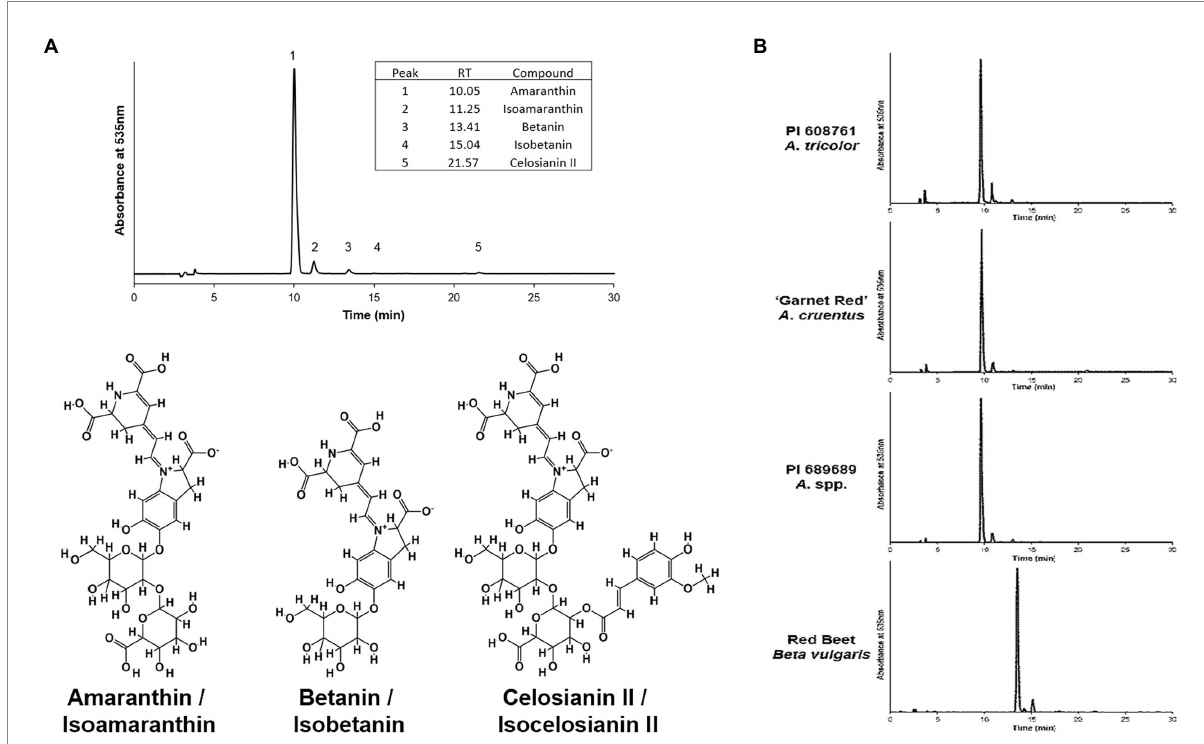
FIGURE 1 (A) Representative HPLC chromatogram of an A. cruentus extract (PI 566897) using the analysis method described by Cai et al. (2001a). Example normalized chromatograms of PI 608761 ( A. tricolor ), ‘Garnet Red’ ( A. cruentus ), PI 689689 ( A. cruentus ), and an extract of store-bought red beet ( Beta vulgaris ) are shown in (B) to emphasize the relatively minor scale of compositional differences between amaranth cultivars and, in contrast, their substantial differences in comparison to betanin-dominant beet